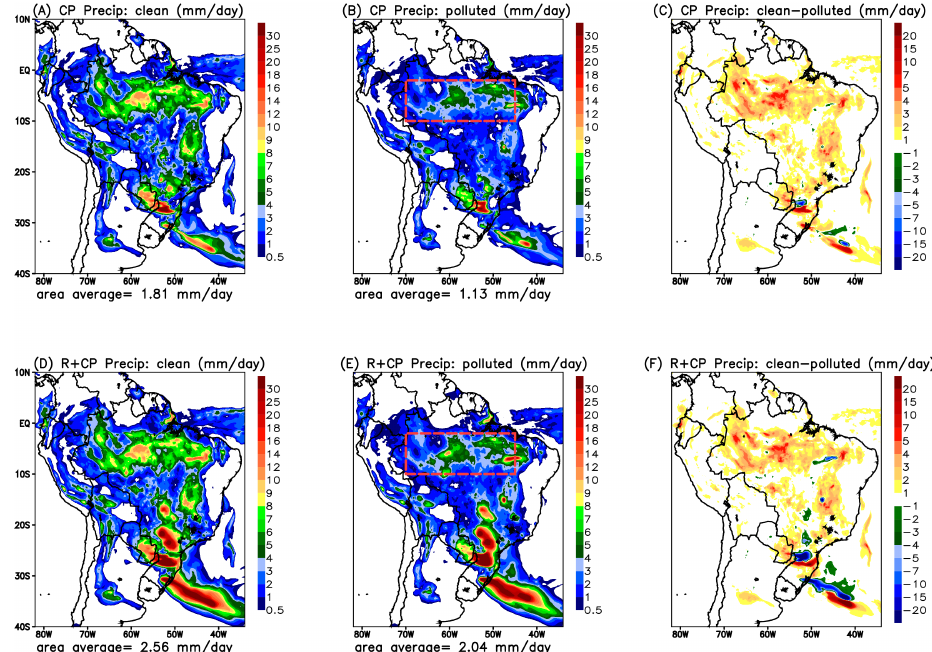
Figure 15. 24h precipitation rates for a run with simulated clean conditions (A, D) , polluted conditions (B, E) , convective, non-resolved precipitation (A, B) , the difference between clean and polluted run for convective precipitation (C) , and total accumulated precipitation (D, E) and the differences between the clean and the polluted run for the total precipitation (F).